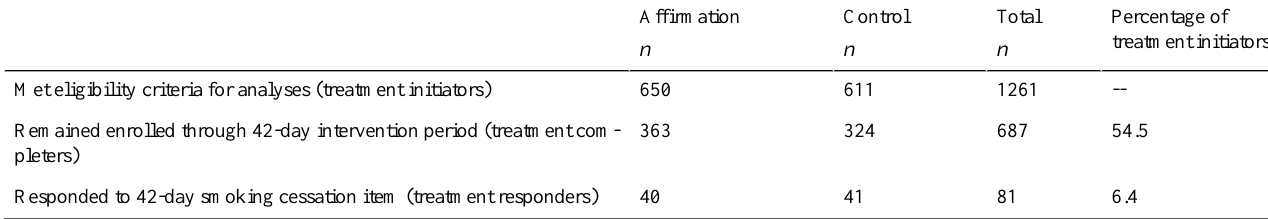
Percentage of initiatorsTotal Control treatment n n